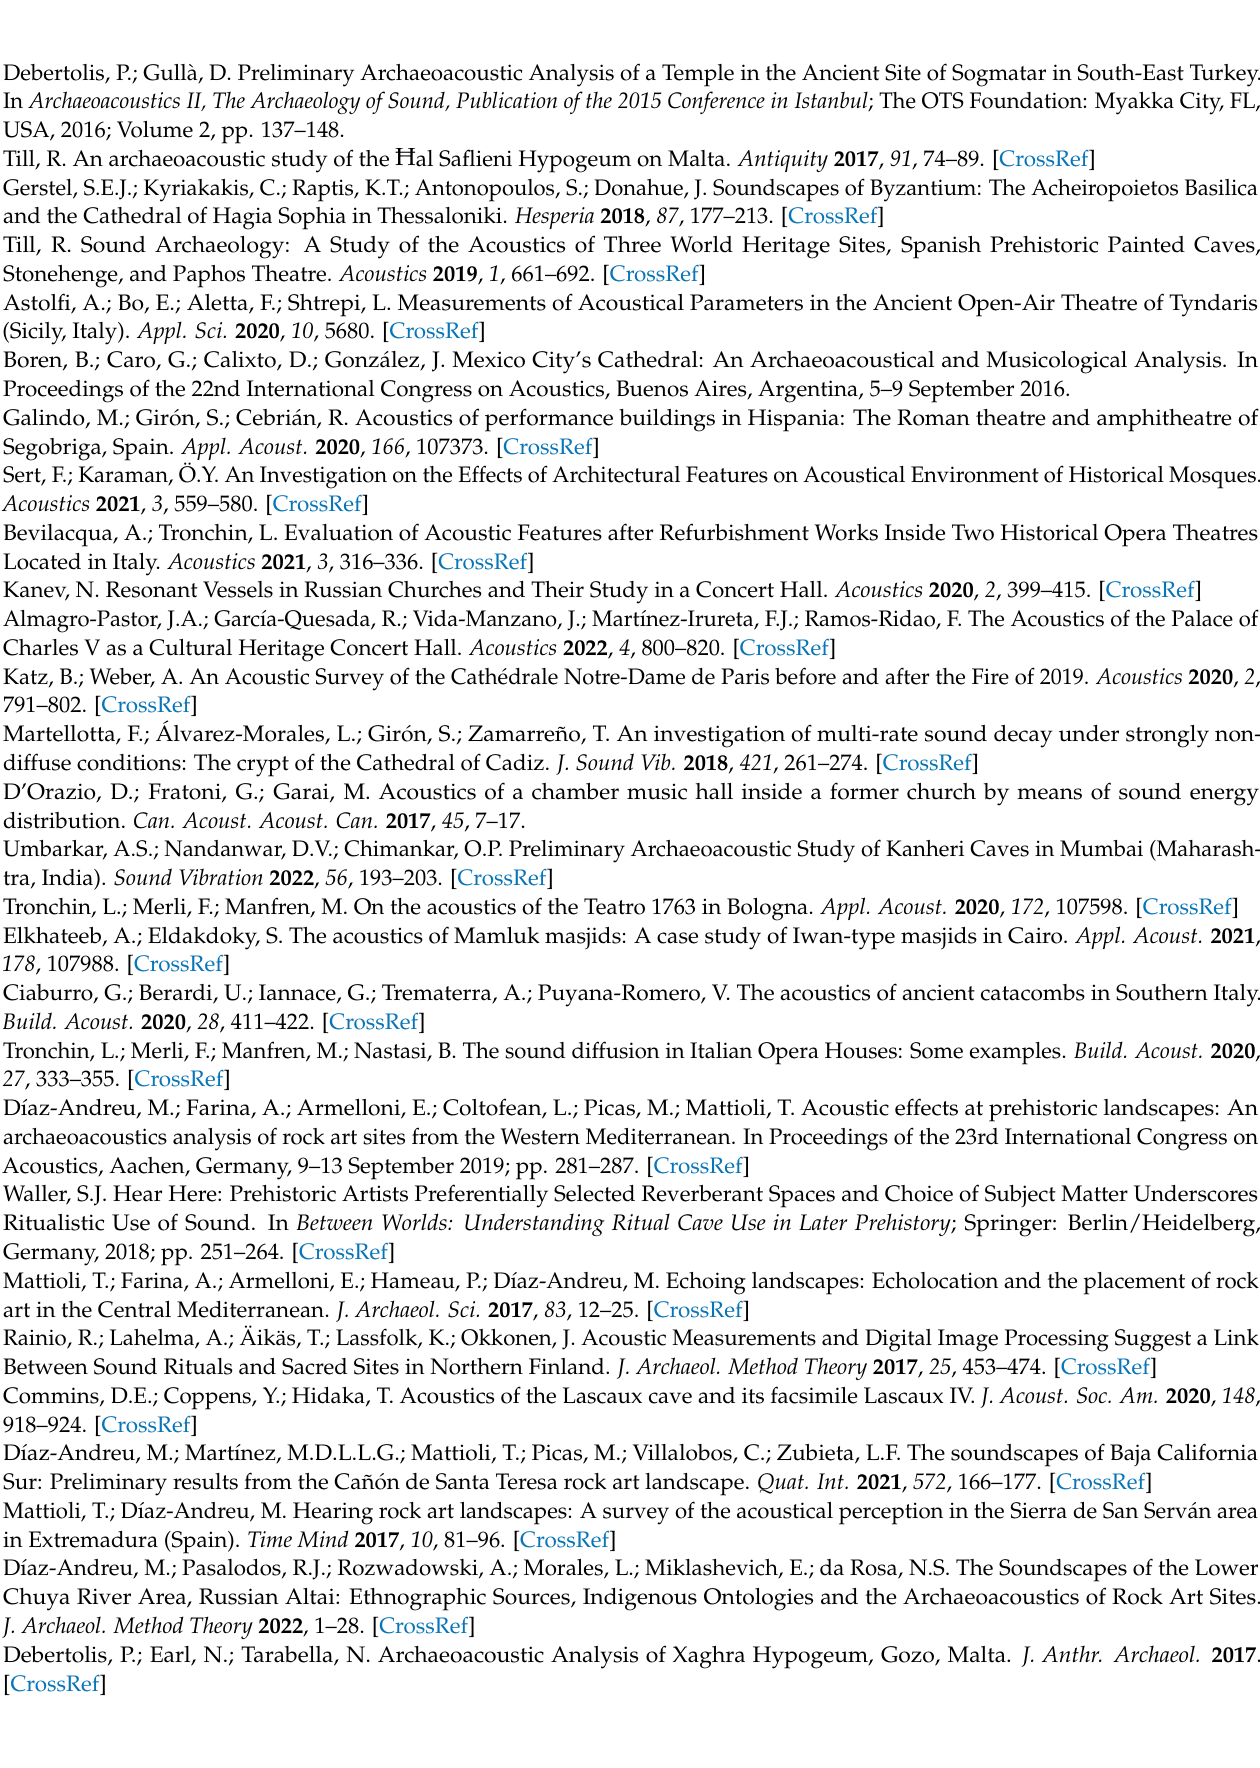
Table 1. Archaeoacoustics measurement and characterization of historical worldwide